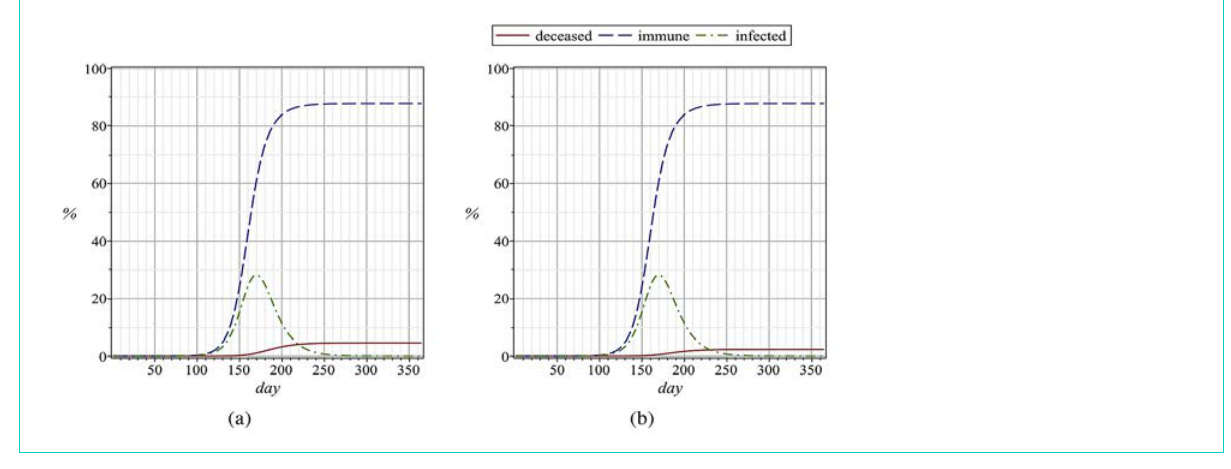
) and solid lines the de- 𝑖𝑖𝑢𝑢𝑢𝑢𝑢𝑢𝑢𝑢𝑢𝑢 𝑖𝑖𝑢𝑢𝑢𝑢𝑢𝑢 𝑛𝑛 + 𝑛𝑛